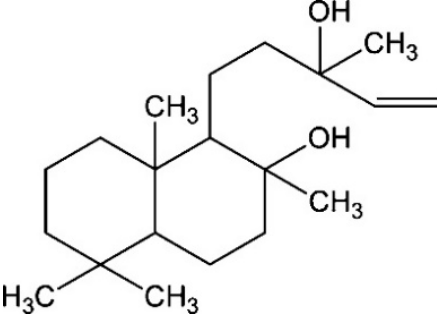
Figure 1. Chemical structure of sclareol (MW 308.50).